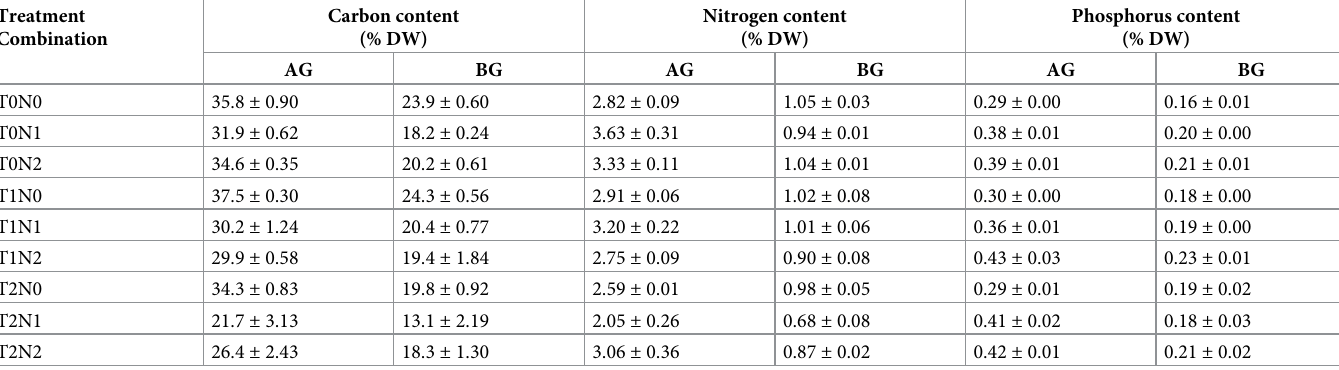
Table 2. Carbon, nitrogen, phosphorus contents (% DW) in aboveground (AB) and belowground (BG) parts of Z . capensis subjected to combined effects of increased nutrient and temperature. T0 = 18˚C, T1 = 24˚C and T2 = 30˚C; N0 = no nutrients, N1 = moderate enrichment, N2 = high enrichment. Mean ± SE. Treatment